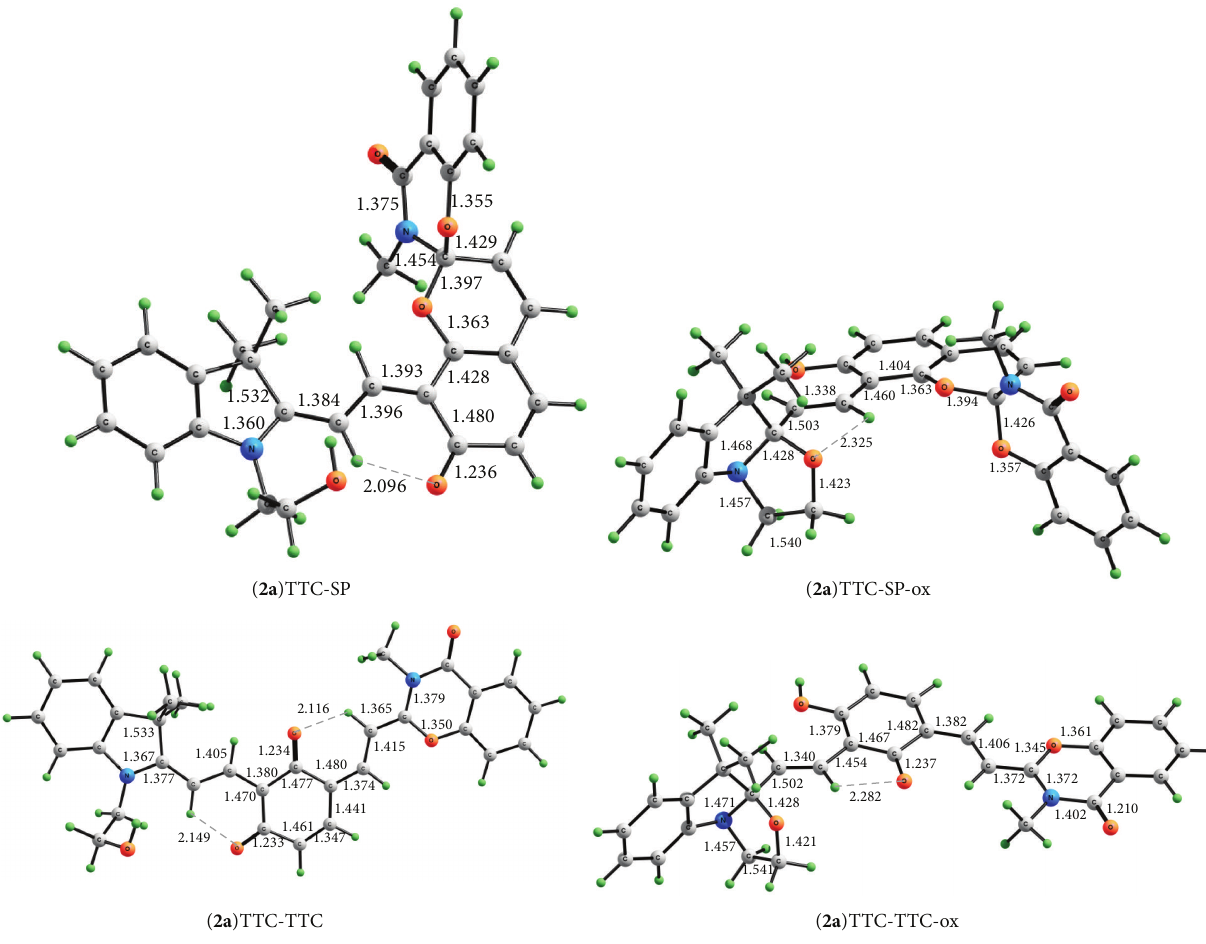
Figure 4: Structural properties of merocyanine isomer ( 2a )TTC-SP, oxazolidine form ( 2a )TTC-SP-ox, ( 2a )TTC-TTC, and oxazolidine form ( 2a )TTC-TTC-ox calculated at the CPCM/PBE0/6-311G ∗∗ level of theory (toluene solutions).